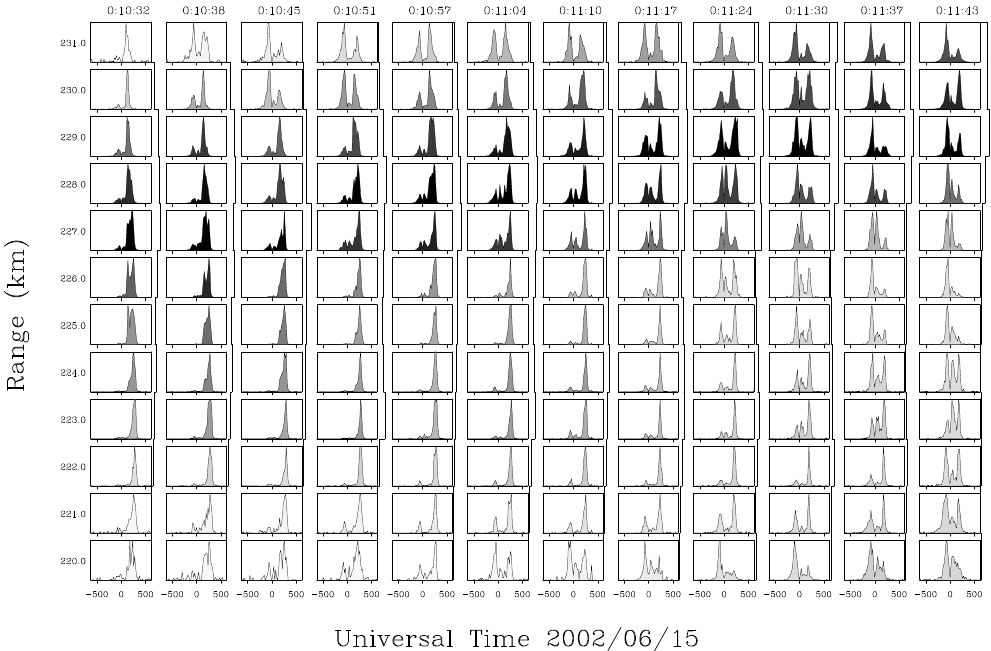
Fig. 8. Doppler spectra for echoes received between 220–231km range, 00:10:32–00:11:43UT. The narrow spectral forms with Doppler shifts close to +250m/s are type I spectra, indicative of modified two-stream instabilities.